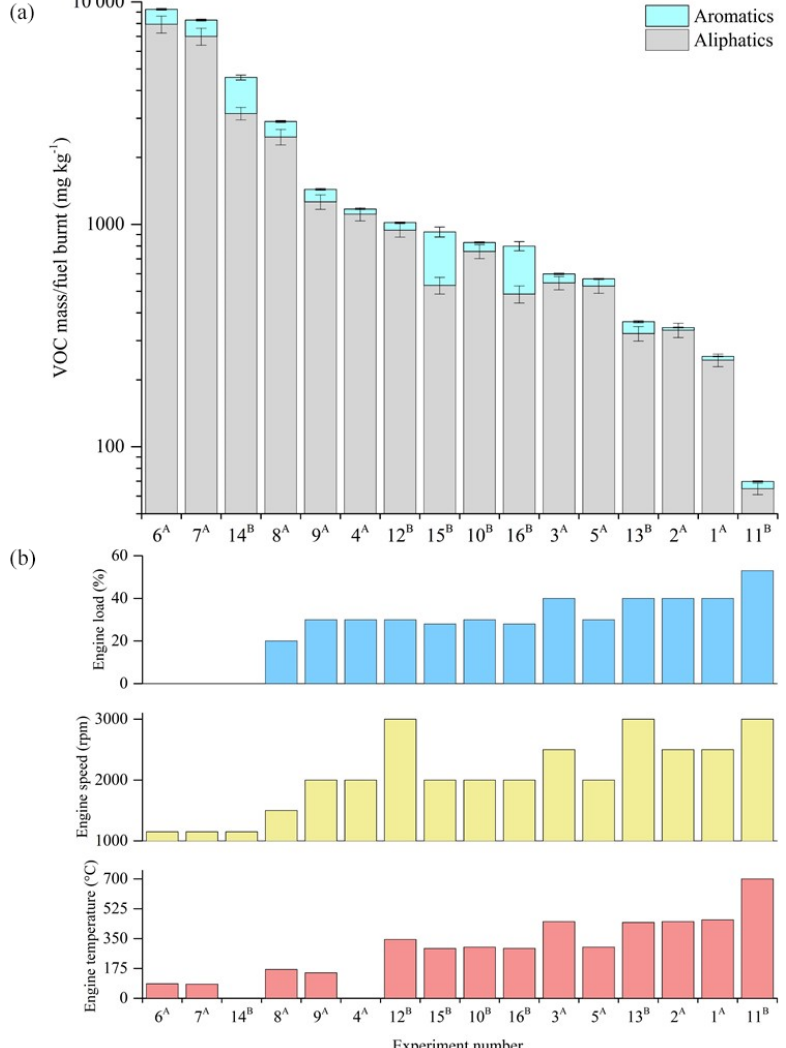
Figure 11. Total speciated VOC-IVOC emission rate measured in each experiment (refer to Table 1) divided into aliphatic and aromatic emissions rates (a) . Experiments ordered from left-to-right by decreasing VOC-IVOC emission rates. Engine temperature, speed, and load in each corresponding experiment are shown in (b) . (a) Fuel batch A used (see Sects. 2.3 and 3.1.1). (b) Fuel batch B used. No DOC in exp. 3. Sequence of engine conditions performed in exps. 9 and 8 (see Sect. 2.1 and Fig. S1). No engine temperature measurement for exps. 4 and 14 (engine thermocouple unresponsive). Error bars represent the calculated uncertainty in the measured emission rates, see Sect. S1.1 for further